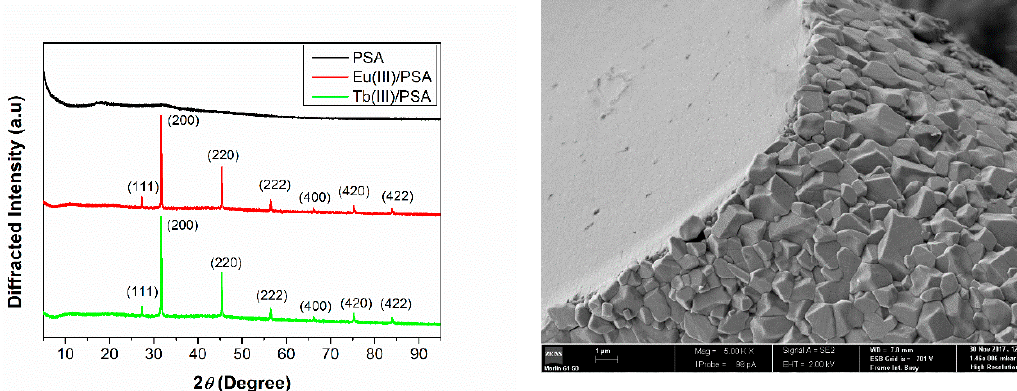
Figure 2. XRD patterns of PSA (black), Eu 3+ /PSA (red) and Tb 3+ /PSA (green), ( left ) and SEM micrograph of Eu 3+ /PSA freeze drying composite ( right ). Magnification 5000×.